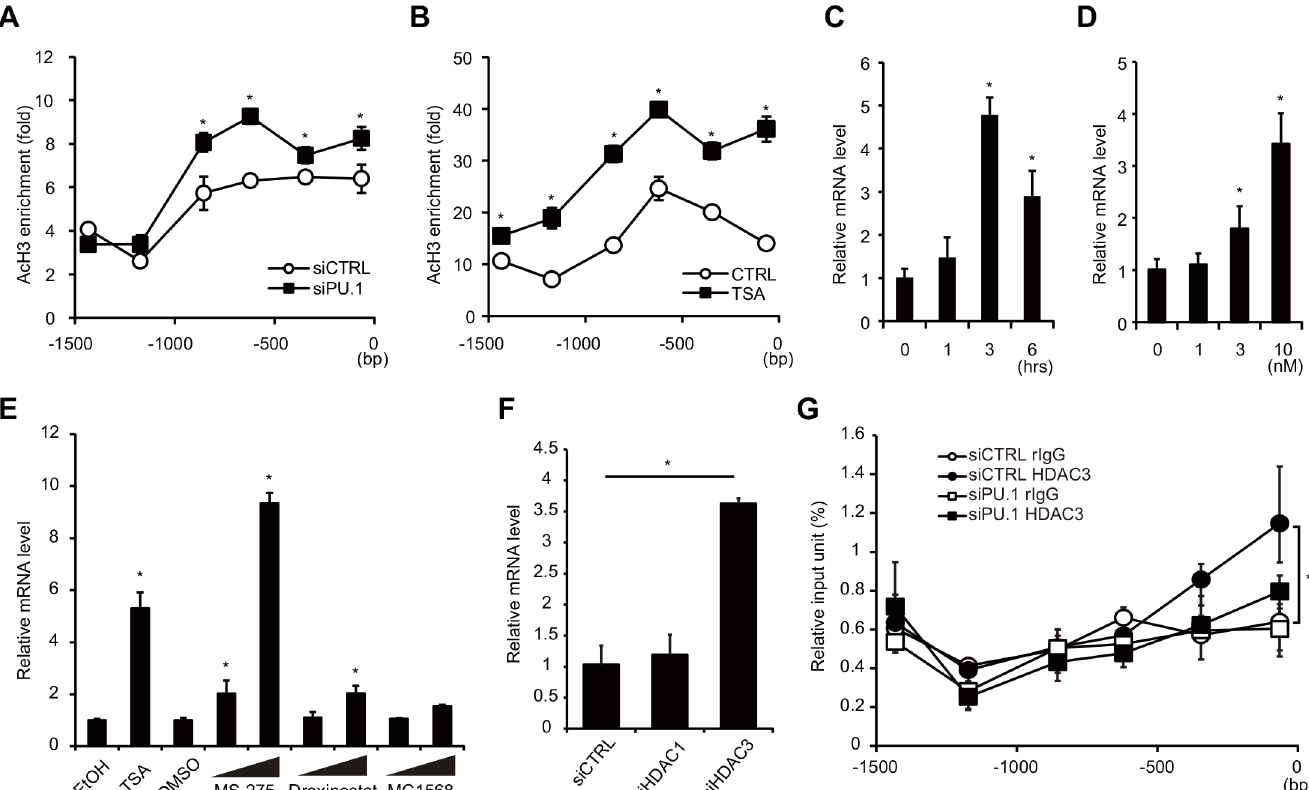
Fig 5. Effects of PU.1 knockdown on the histone acetylation and on HDAC recruitment at the Gata3-1b promoter. Histone acetylation status of the Gata3-1b promoter in BMDCs transfected with either PU.1 siRNA (siPU.1) or its control siRNA (siCTRL) (A), and the acetylation status in BMDCs cultured without (CTRL) or with 10 nM the histone deacetylation inhibitor trichostatin A (TSA) for 3 h (B). Quantification of acetyl-histone H3 at the Gata3-1b promoter was performed by ChIP assay. (C, D) GATA3 mRNA levels in BMDCs cultured with 10 nM trichostatin A for the indicated times (C) or with the indicated trichostatin A concentration for 3 h (D). Effects of HDAC inhibitors (E) and knockdown of HDACs (F) on GATA3 mRNA levels. BMDCs were treated with MS- 275 (1 μ M, 10 μ M), Droxinostat (20 μ M, 50 μ M), or MC1568 (5 μ M, 20 μ M) for 6 h (E). Relative mRNA levels (GATA3-1b/GAPDH) were determined by quantitative RT-PCR after normalizing to GAPDH mRNA. (G) The binding degree of HDAC3 on the Gata3-1b promoter was analyzed by a ChIP assay. Open circles, control rabbit IgG binding in control siRNA-transfected cells; closed circles, anti-HDAC3 antibody binding in control cells; open squares, control IgG binding in PU.1 siRNA-transfected cells; closed squares, anti-HDAC3 antibody binding in PU.1 siRNA-transfected cells. All results are means ± S.E.s ( n = 3). Similar results were obtained in three separate experiments. * , p < 0.05 in a two-tailed paired Student ’ s t test.